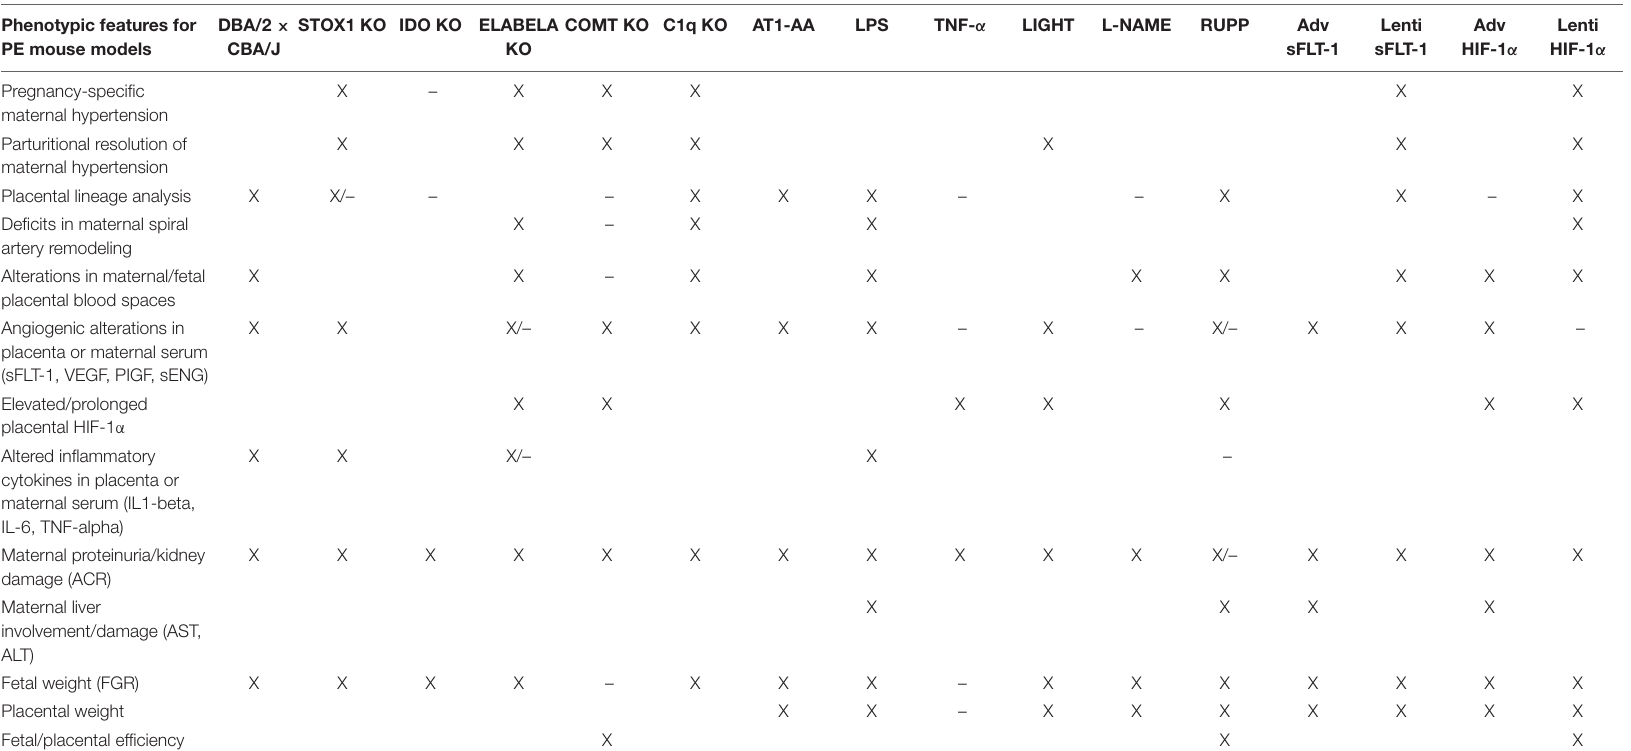
TABLE 2 | Proposed standardization and reported phenotype in mouse models of PE. Phenotypic features for PE mouse